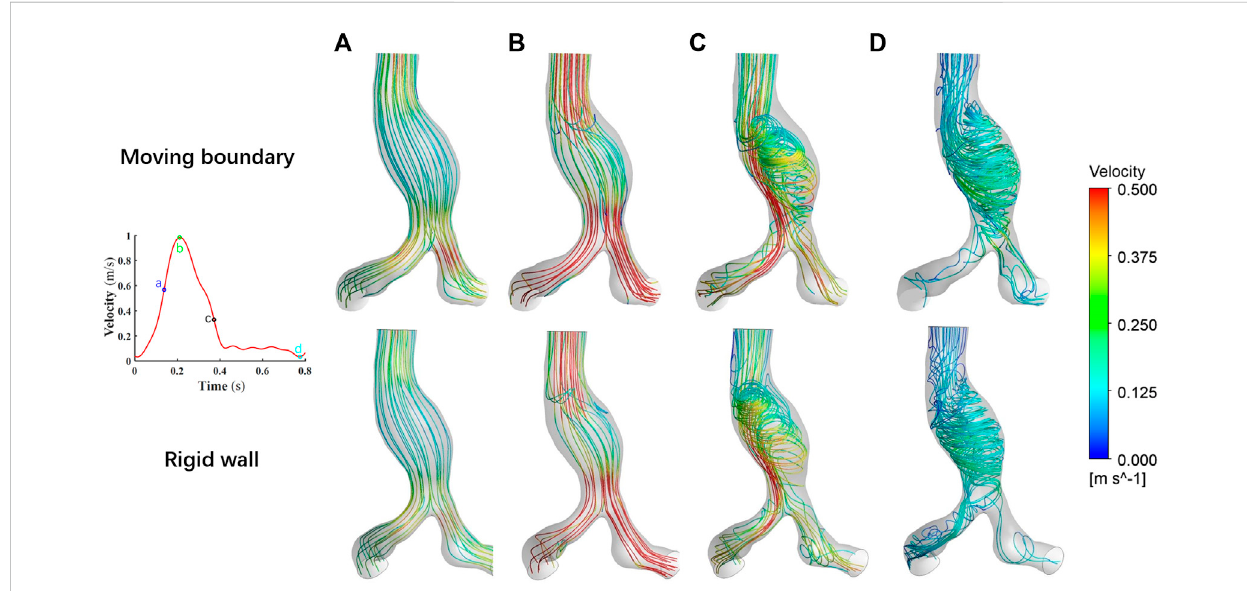
FIGURE 7 Comparison of the fl ow fi elds at four speci fi c time points by using two methods. (A) Time moment of maximum acceleration of velocity, (B) Time moment of maximum velocity, (C) Time moment of maximum deceleration of velocity and (D) Time moment of minimum velocity.